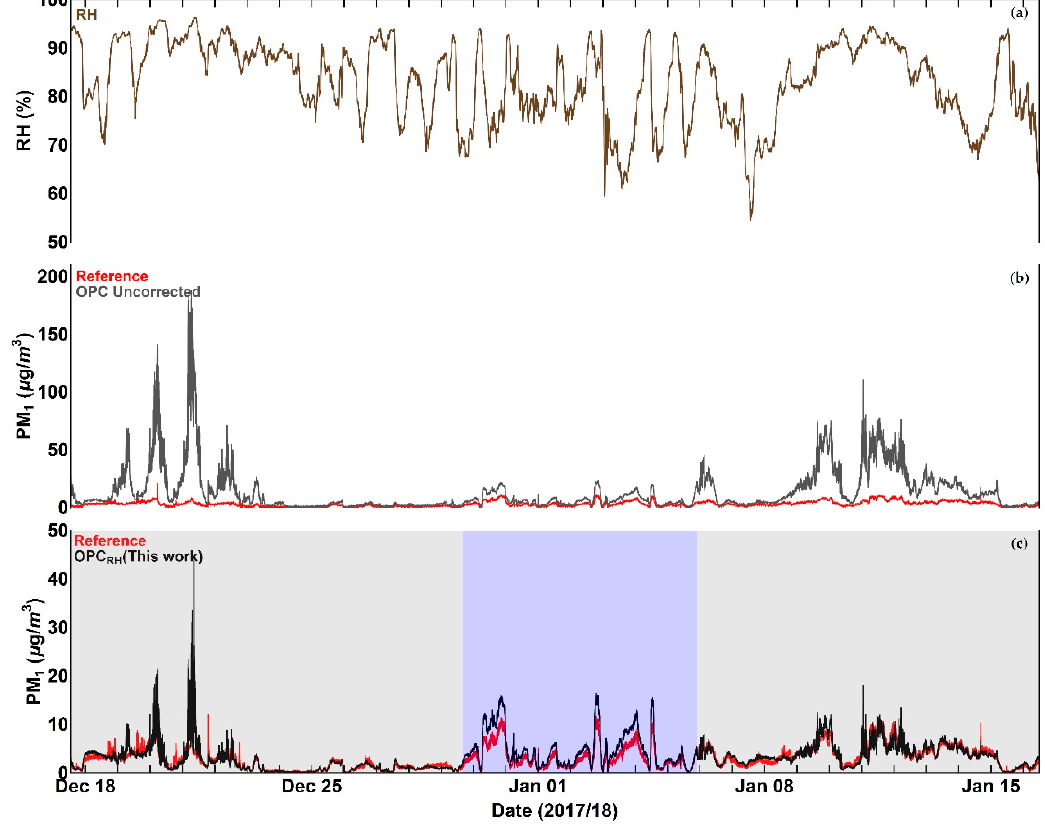
Figure 9. Time series plots of ( a ) Relative Humidity, ( b ) OPC PM 1 measurement in comparison with reference data before the application of the correction algorithm, and ( c ) OPC PM 1 measurement in comparison with reference after the application of the correction algorithm. The blue shaded area denotes a period during which the corrected PM values show a systematic overestimation compared to with reference data. More details are given in the text.